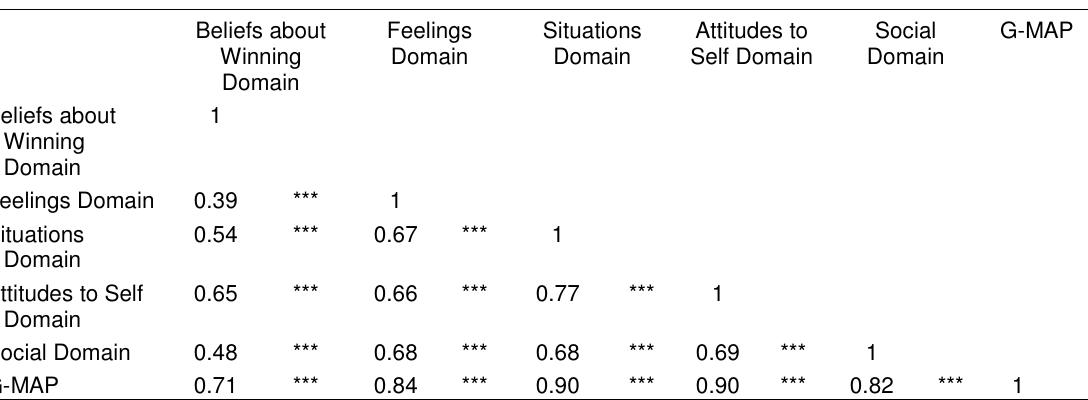
Correlations Among the G-MAP Domain